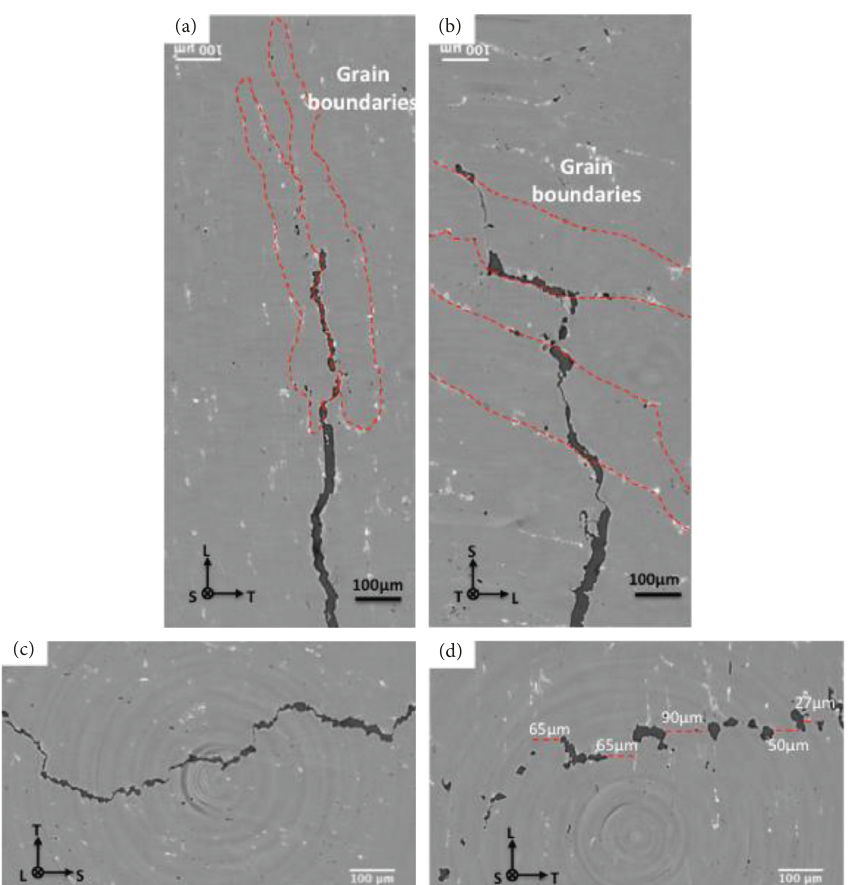
Figure 9: 2D sections of the SRCTdata through white lines in Figure 8 for (a) TL and (b) LS configurations as well as through green lines in Figure 8 for (c) TL and (d) LS configurations.